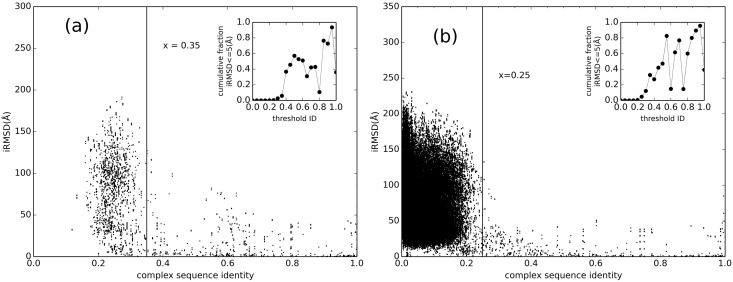
Binding modes vs. sequence identity.For local (a) and global (b) sequence alignments, IRMSD is plotted against the complex sequence identity (the smallest of the monomers sequence identity), in all-to-all pairwise comparison of 439 binary complexes. The data for the local alignment is restricted to alignments with coverage ≥ 0.3 (see text). The insets show the fraction of complex pairs with IRMSD ≤ 5 Å plotted in 0.05 bins to show the phase transition, indicated by the vertical lines on the main plot.